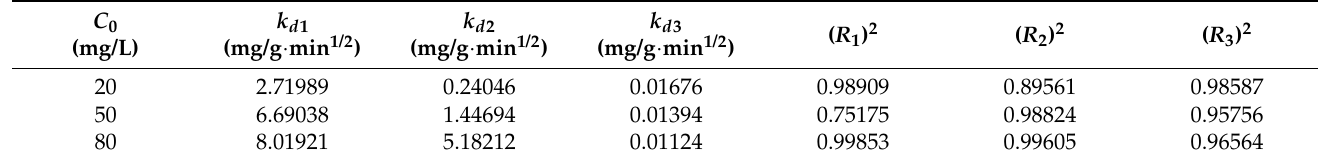
Table 4. Intraparticle diffusion model parameters of MO on CoO@C-500.